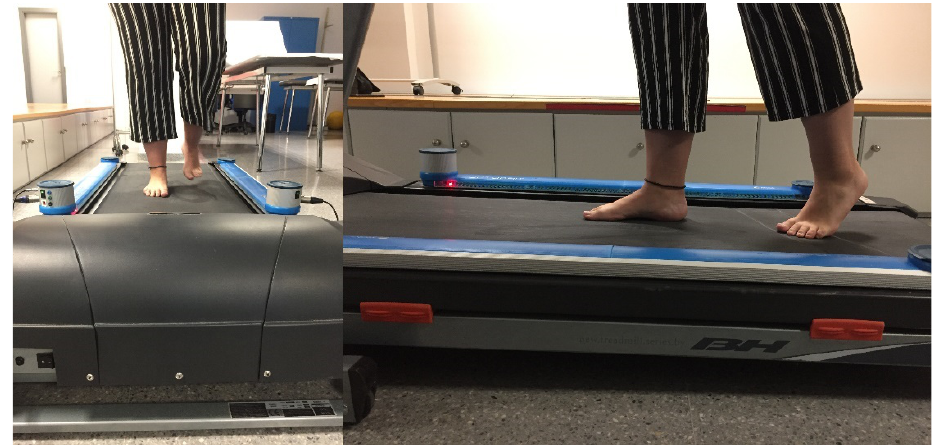
Figure 2. Gait analysis with OptoGait.